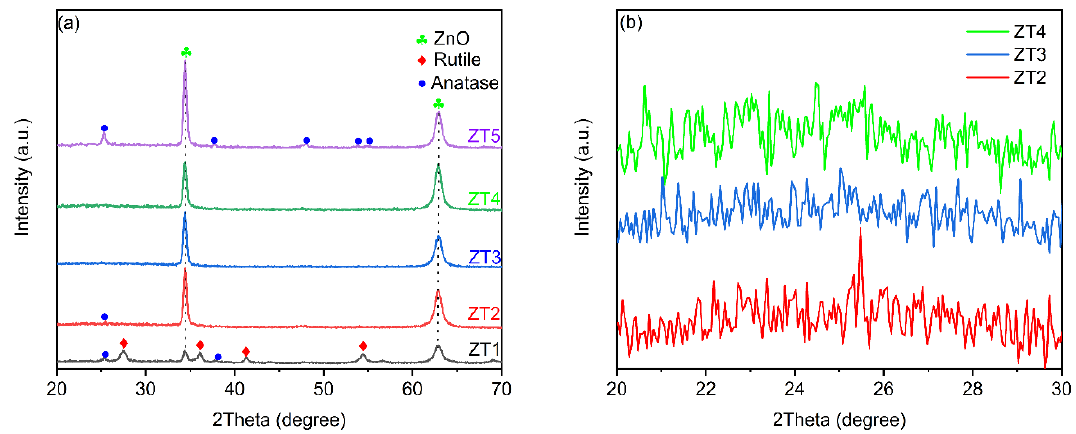
Figure 3. ( a ) XRD patterns of ZT1, ZT2, ZT3, ZT4, and ZT5; ( b ) Zoomed-in details of ZT2, ZT3 and ZT4. Raman was used for further exploring the crystal structure of ZT3 and ZT4. The Raman spectra of ZT3 and ZT4 were given in Figure 4. Figure 4 shows that there is no distinct peak corresponding to any of the crystalline phases of TiO 2 in ZT4 and only a weak peak at 144 cm − 1 responding to the Eg(A) mode of anatase TiO 2 [30], indicating that the ZT4 consists of ZnO and amorphous TiO 2 and the upper TiO 2 layer in the ZT3 is composed of amorphous TiO 2 and a small fraction of anatase. Thus, the XRD pattern of ZT3 shows